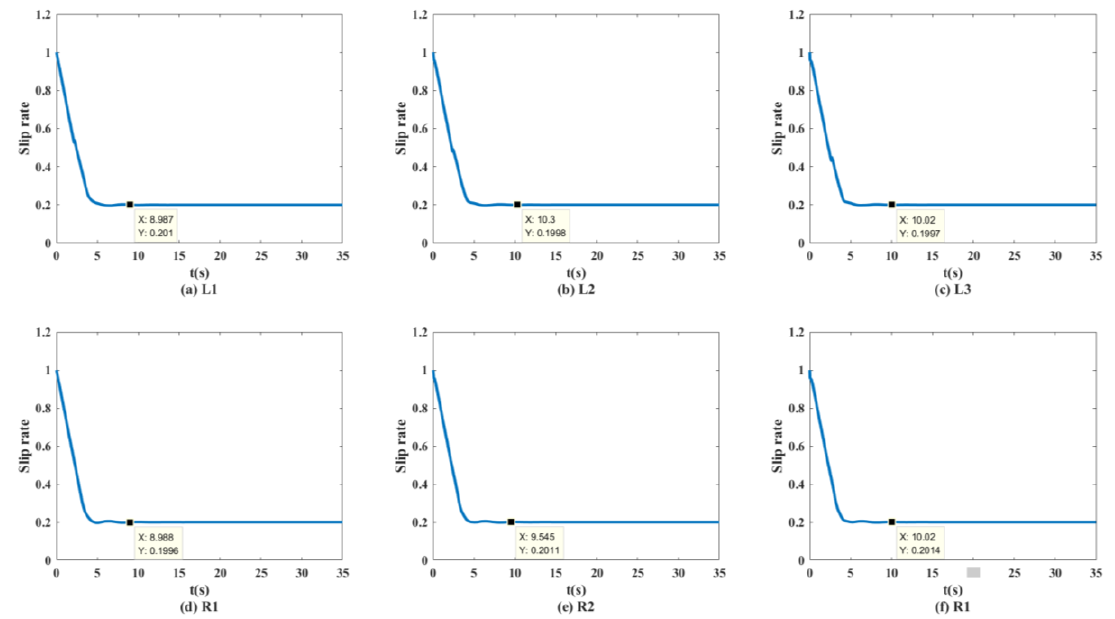
Figure 15. Wheel slip rate of the distributed unmanned vehicle at 50 km/h on the split mu straight road.